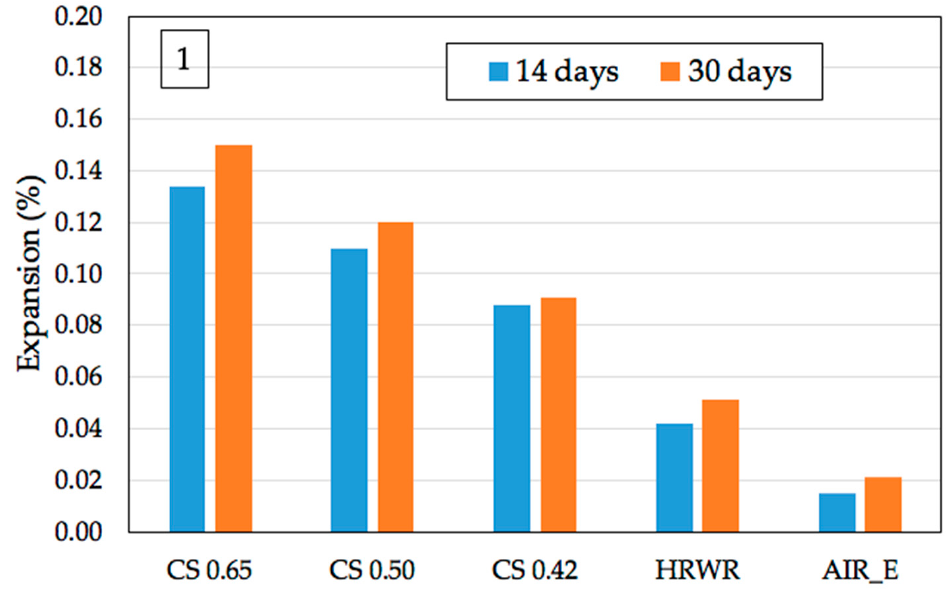
Figure 4. Mortars’ expansion according to Procedure 1.